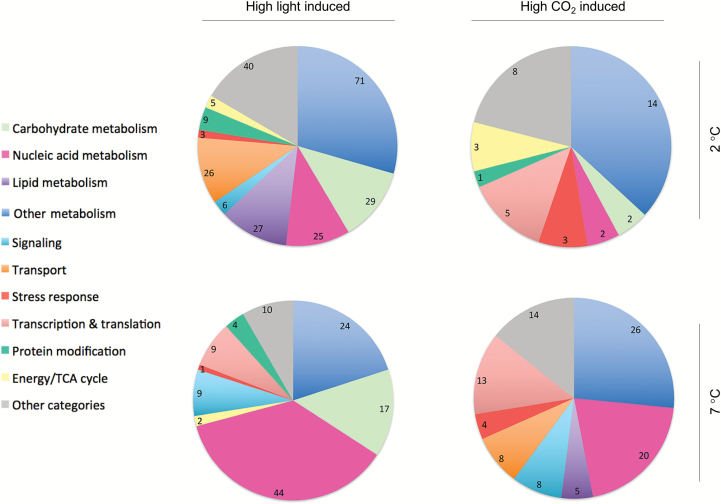
Relative distribution of putative functional categories derived from enriched GO terms of differentially expressed genes driven by high irradiance (intersection between HLA and HLC) or high CO2 (intersection between LLC and HLC) at the two tested temperatures (2 and 7 °C). All of them were compared against the control (2-LLA). Classification of enriched GO terms was made using cateGOrizer (EGAD2GO classification file). TCA, tricarboxylic acid.